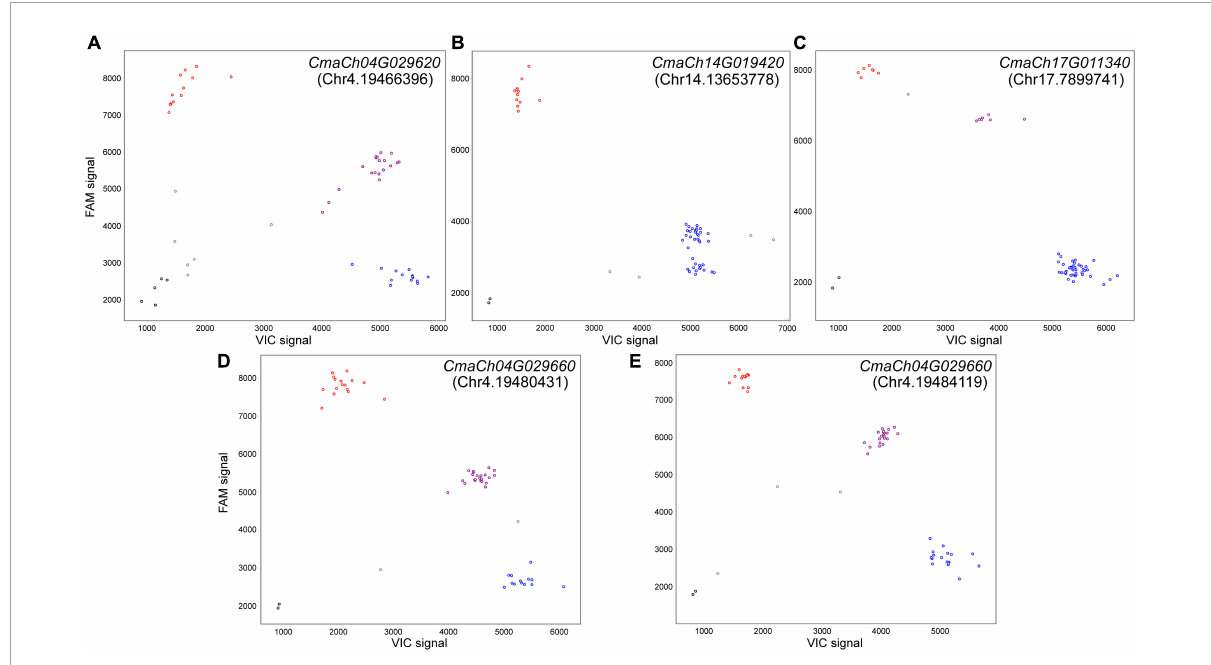
FIGURE5 Analysis of the Kompetitive Allele Specific PCR (KASP) Results for genotyping. Scatter plots show the selected KASP assays clustering of varieties on the X-(VIC) and Y-(FAM) axes. The purple dot represents heterozygous genotype and blue and red dots represent the homozygous genotype of two parents (Atlantic Giant and Hubbard), 40 F 2 individual plants and six cultivars showing extreme fruit sizes. The black dots represent the genotype is dropped out and gray dots represent the NTC (non-template control). The positions of these insertion-deletions (inDels) and Single Nucleotide Polymorphism (SNPs) were presented in parentheses. Marker for (A) inDel in CmaCh04G029620 , (C) SNP in CmaCh17G011340 and (D,E) SNP in CmaCh04G029660 showing three distinct clusters. (B) Marker for inDel in CmaCh14G019420 showing two distinct